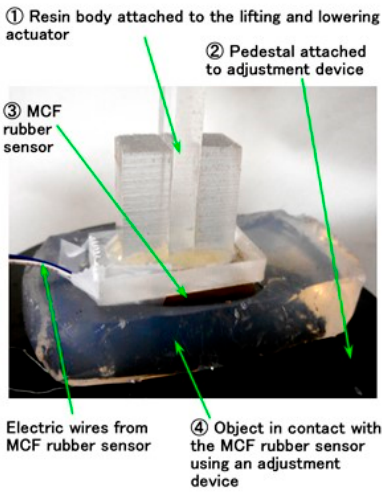
Figure 11. Image of touching the silicone gel by the MCF rubber sensor.